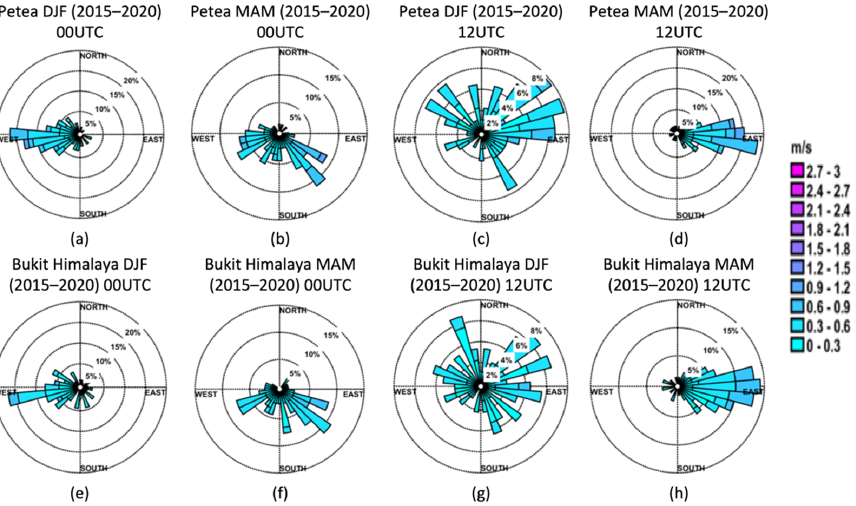
Figure A1. ( a ) Wind regime at Petea Tower in DFJ at 00 UTC; ( b ) wind regime at Petea Tower in MAM season 00 UTC; ( c ) same as ( a ) but at 12 UTC; ( d ) same as ( b ) but at 12 UTC; ( e ) wind regime at Himalaya Hill Tower in DJF at 00 UTC; ( f ) wind regime at Bukit Himalaya Hill Tower in MAM at 00 UTC; ( g ) same as ( e ) at 12 UTC; ( h ) same as ( h ) at 12 UTC.